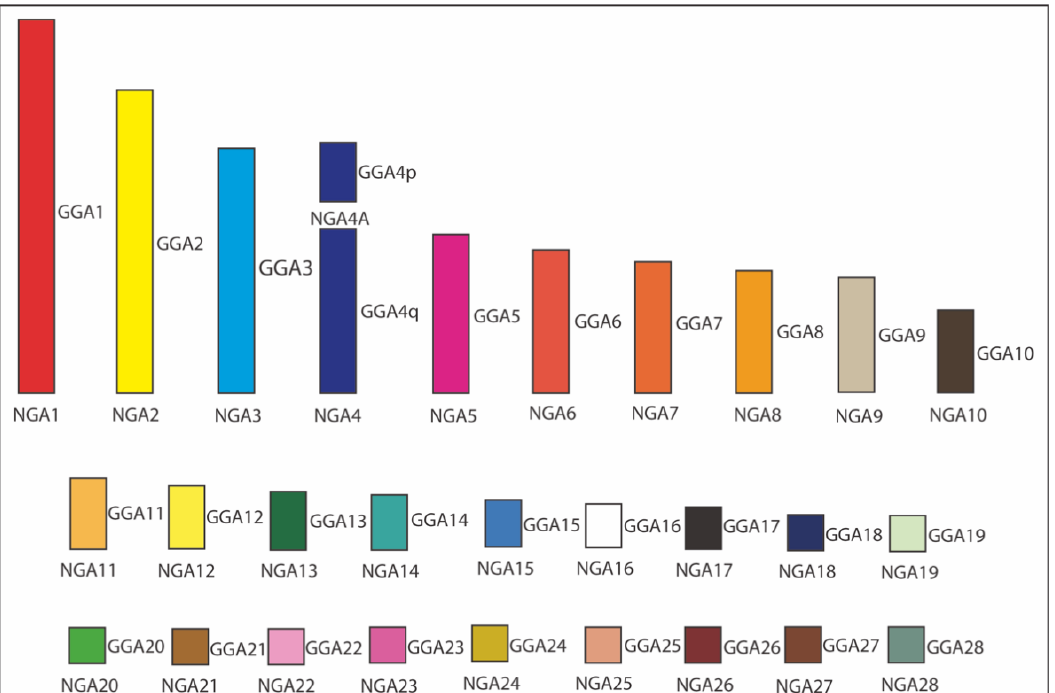
Figure 5. Ideogram of Neognathae ancestor (NGA) karyotype (NGA1 to NGA28). The NGA ancestral karyotype is likely to have the same homology with chicken ( Gallus gallus ; GGA), except GGA4 split into two separated chromosomes. Each GGA chromosome is illustrated with a different color. The white color indicates the probable homology with GGA16.